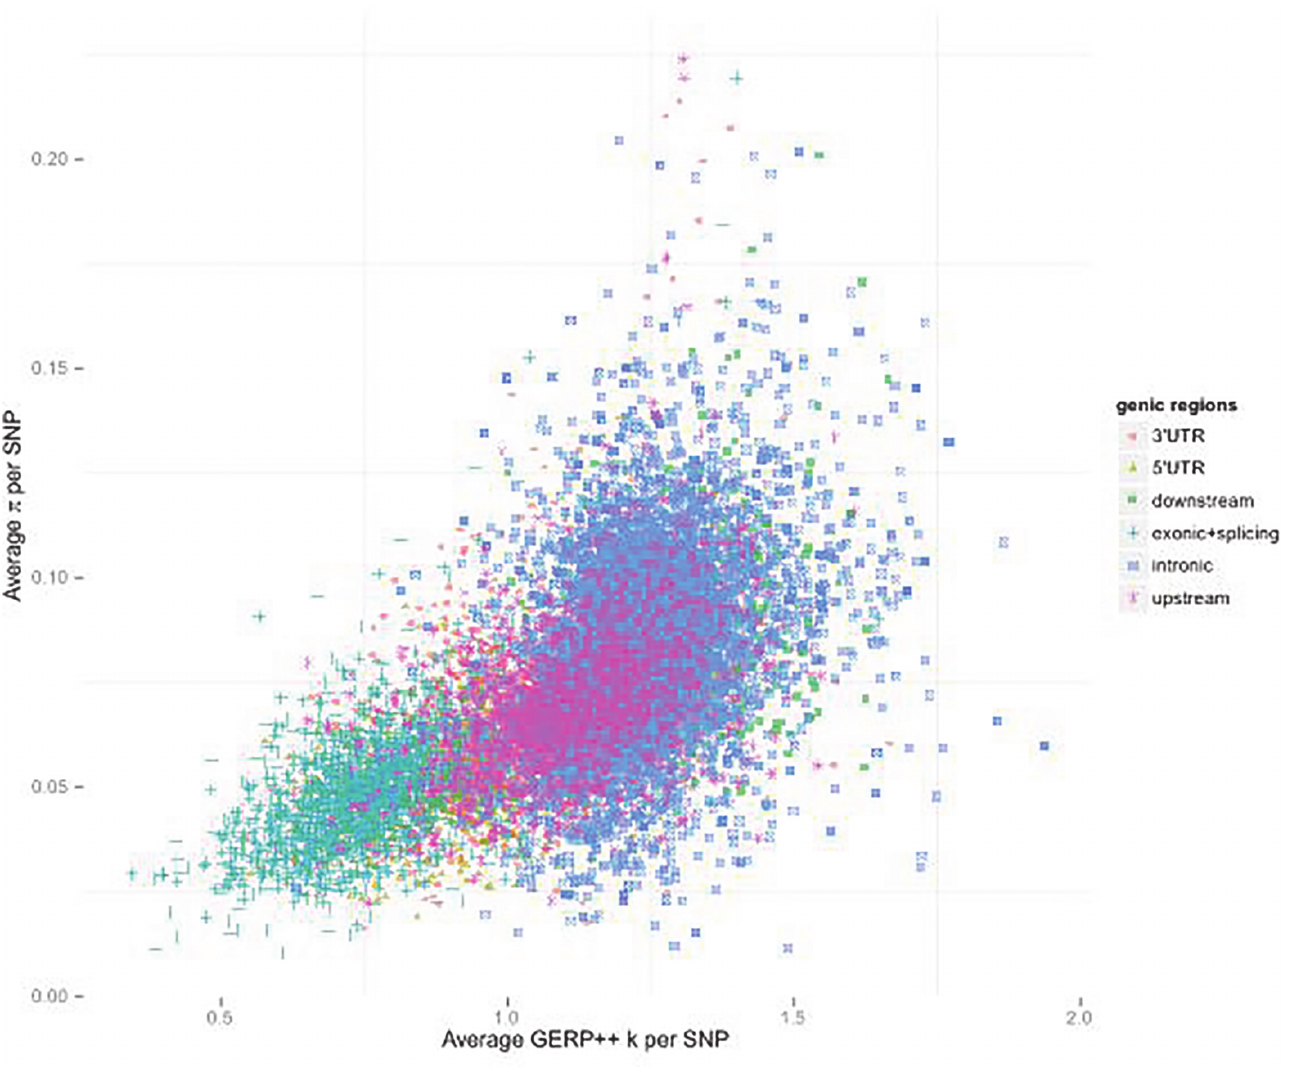
Fig 3. The average π and GERP++ k of the SNPs discovered in 14,501 major domains of genic regions x function groups. π measures nucleotide pairwise difference and the conservation score GERP++ measures divergence among species. GERP++ score is divided by its corresponding neutral mutation rate to produce a normalized score (called GERP++ k), for which a smaller number indicates a lower divergence (i.e. higher conservation) on the